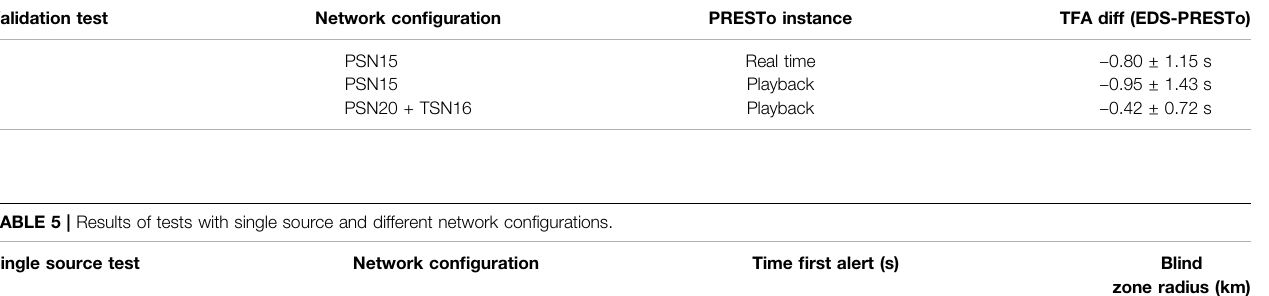
TABLE 4 | Results of the TFA comparison relative to real time and in playback PRESTo instances.